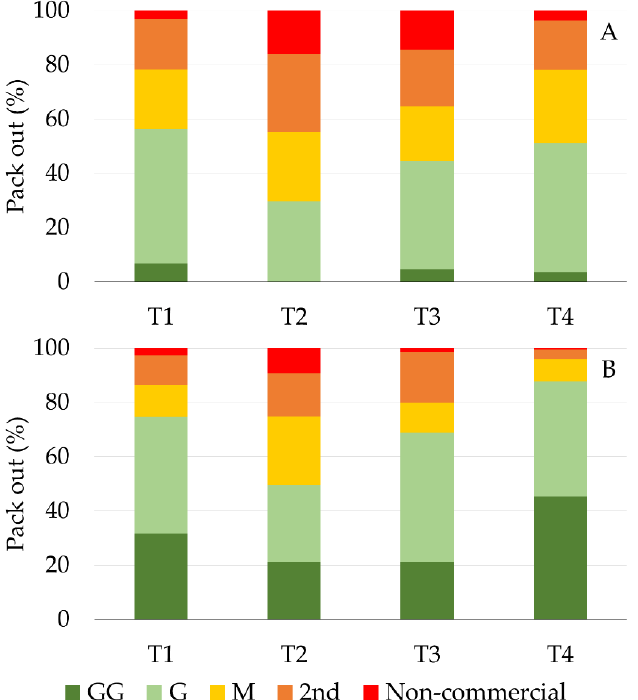
Figure 3. Pack out at harvest as fruit size distribution and damages as follows: GG: 46–52